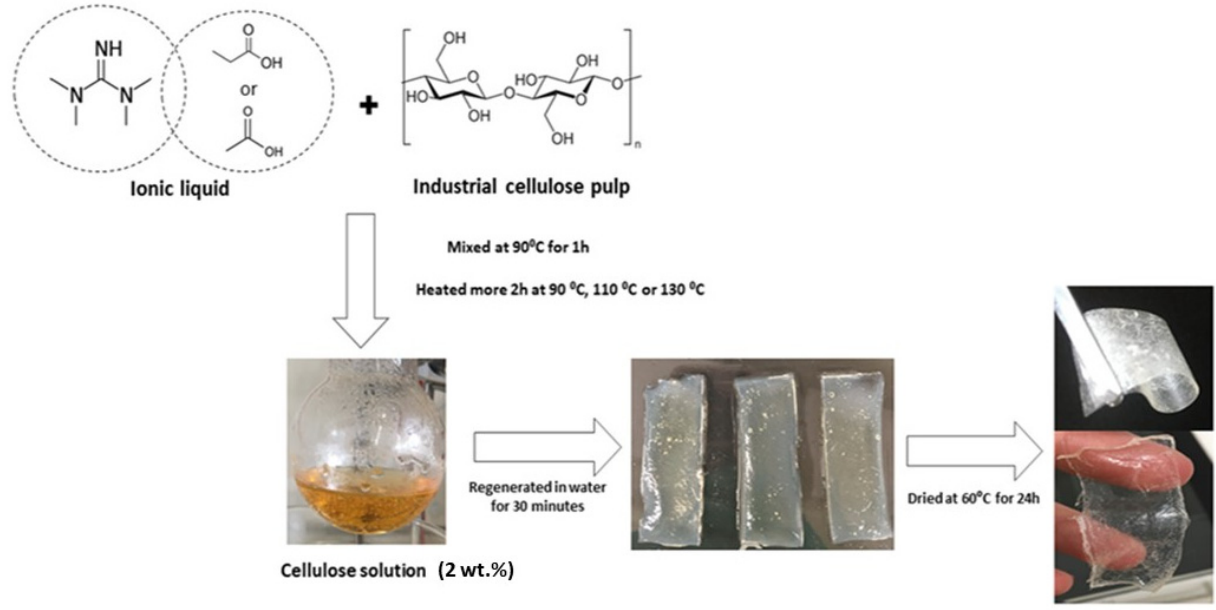
Figure 1. Schematic presentation of industrial pulp dissolution process and its film formation.